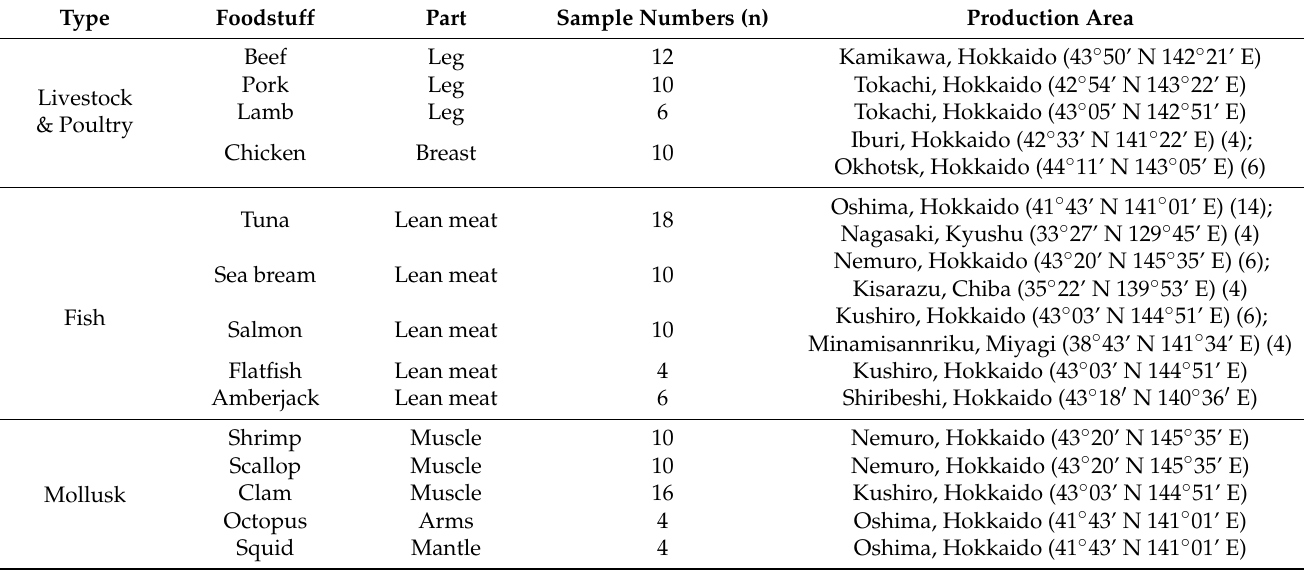
Table 1. Information of the investigated foodstuff